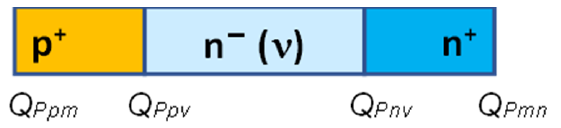
Figure 6. Contact losses in p- ν -n diode.